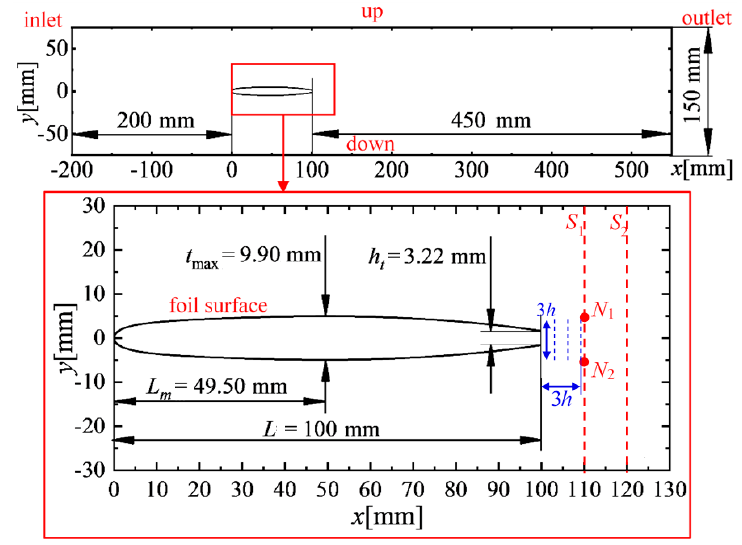
Figure 4. Geometrical diagram of the 2D-CFD case with indications of reference points and lines.